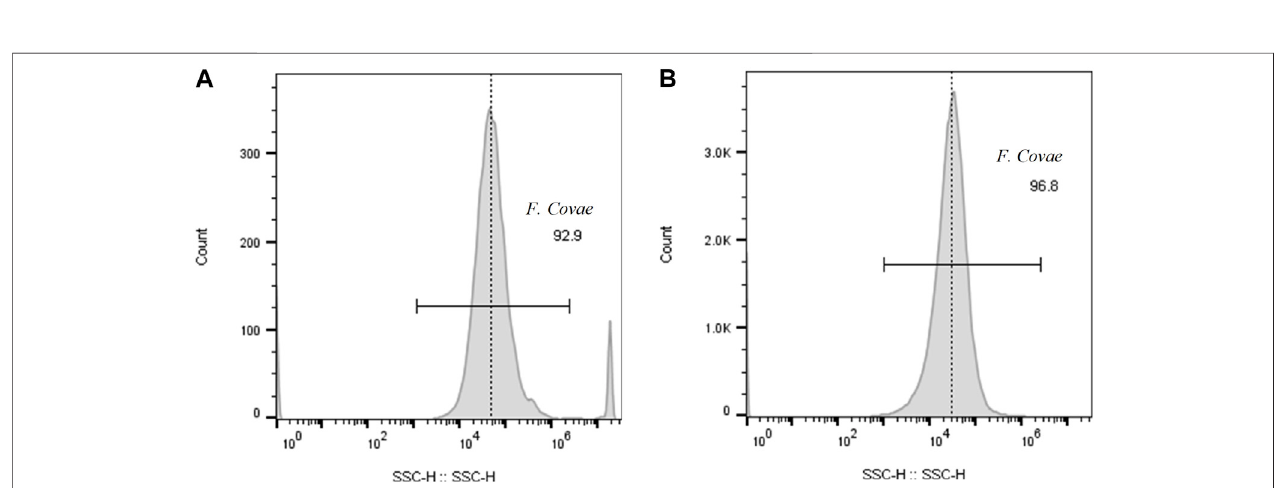
FIGURE 4 | Histogram plots of F. covae cell counts obtained from (A) control tank water samples and (B) tanks exposed to F. covae challenge. Note the scale on the y-axis in (B) is an order of magnitude higher than (A) .